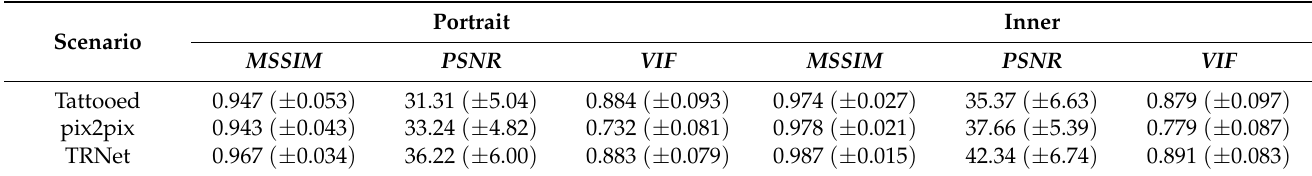
Table 2. Quality measurements of the reconstructed images compared to ground truth images where tattoos have been manually removed. “Tattooed” denotes the baseline case where the tattooed images are compared to the ground truth